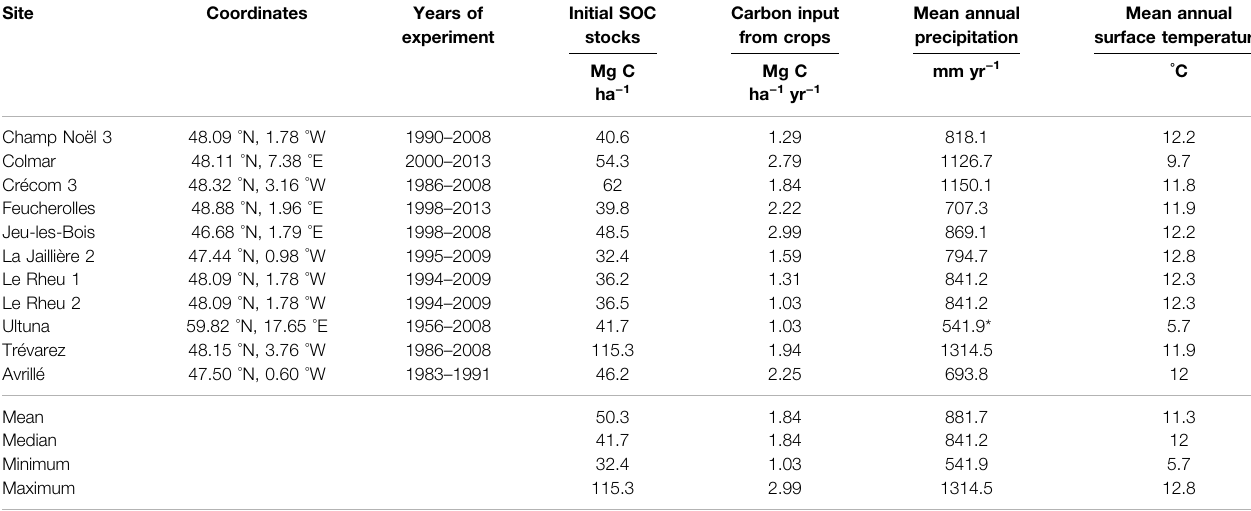
TABLE 1 | Characterization of the control treatments at the long-term experiments (LTEs). Mean annual surface temperature and precipitation were derived from an hourly global climate dataset at 0.5 ° (GSWP3 http://hydro.iis.u-tokyo.ac.jp/GSWP3/).